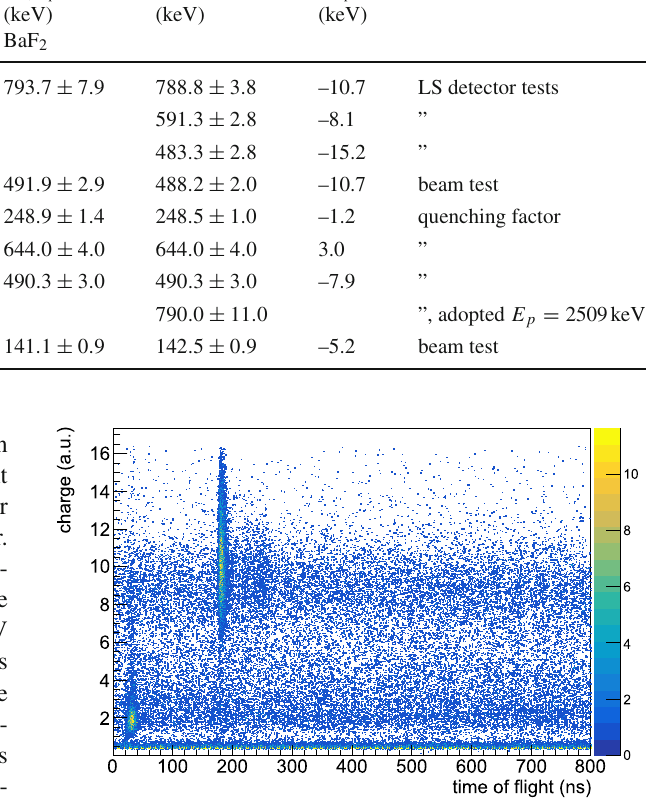
with a laser distance meter and varied between 650mm and 1540mm with an uncertainty of